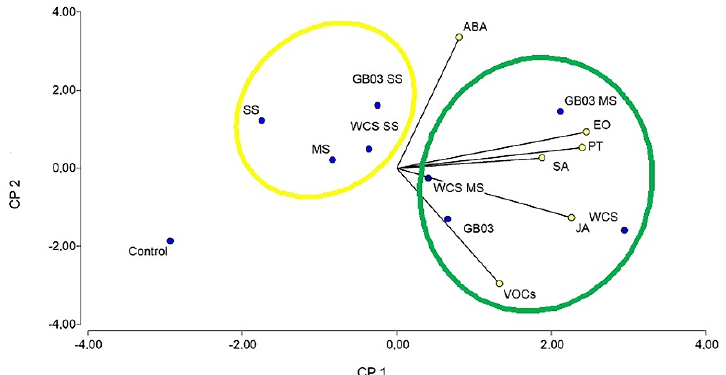
Figure 5. PCA plot for the response of peppermint plants subjected to drought stress inoculated with PGPR strains. Green ellipse, drawn manually, shows a strong effect of MS as well as inoculation treatment (GB03 or WCS417r) or their combination (MS + PGPR) with the variable PT, EO and its emission as VOCs. In contrast, control and SS treatments, alone or combined with GB03 or WCS417r, were located far from the variable assessed (yellow ellipse), representing a minor effect. EO: Essential Oil, VOC: Volatile Organic Compounds, PT: Peltate Trichome; JA: Jasmonic Acid; SA: Salicylic Acid and ABA: Abscisic acid; MS: moderate stress; SS: severe stress.